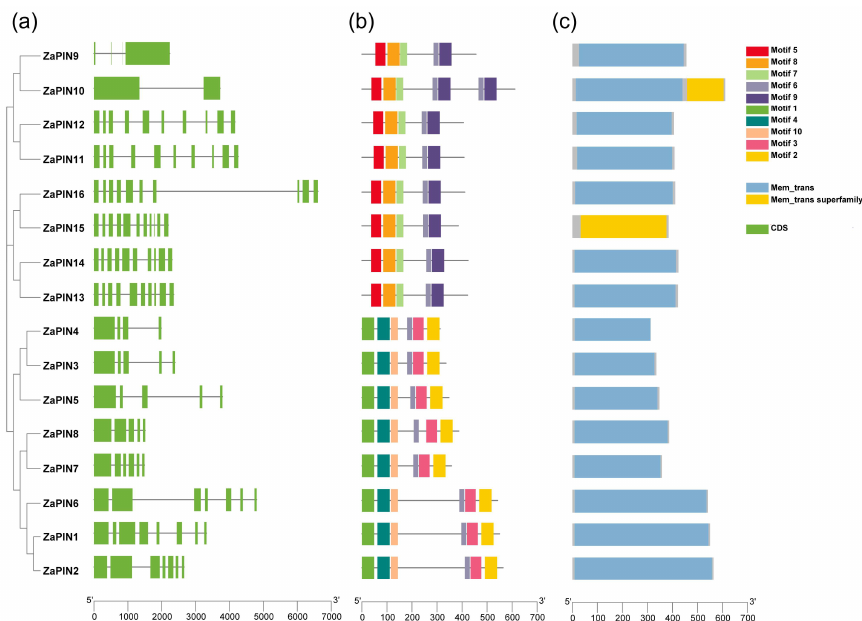
Figure 4. Gene structures and conserved motifs . ( a ) Gene structure of ZaPINs . ( b ) ZaPIN protein conserved motifs; motifs from 1 to 10 are marked by different colors. ( c ) PIN family conserved motifs in Z. armatum, blue box: Mem_trans conserved motif, yellow box: Mem_trans superfamily conserved motif.